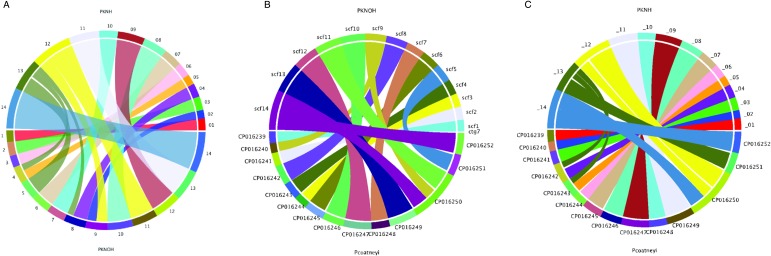
Chromosomal synteny between PKNH and the MaHPIC PKNOH genome sequences. (A) SyMAP
circular DNA comparison of the MaHPIC Pk genome sequence scaffolds to the PKNH 2015
consensus sequence. (B) SyMAP circular DNA comparison of the MaHPIC Pk genome
sequence scaffolds to the Plasmodium coatneyi HACKERI genome
sequence that was assembled using PacBio technologies (Chien et al.
2016). (C) SyMAP circular DNA comparison of
the PKNH 2015 consensus sequence and P. coatneyi genome
sequence.